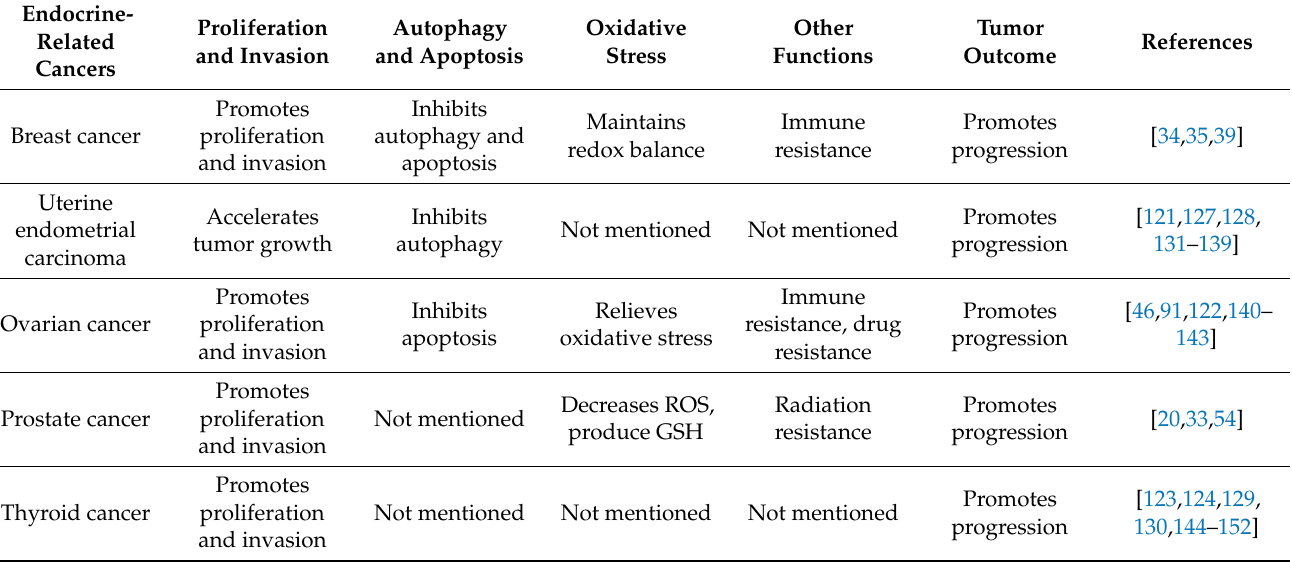
Table 2. Influence of glutamine metabolism on endocrine-related